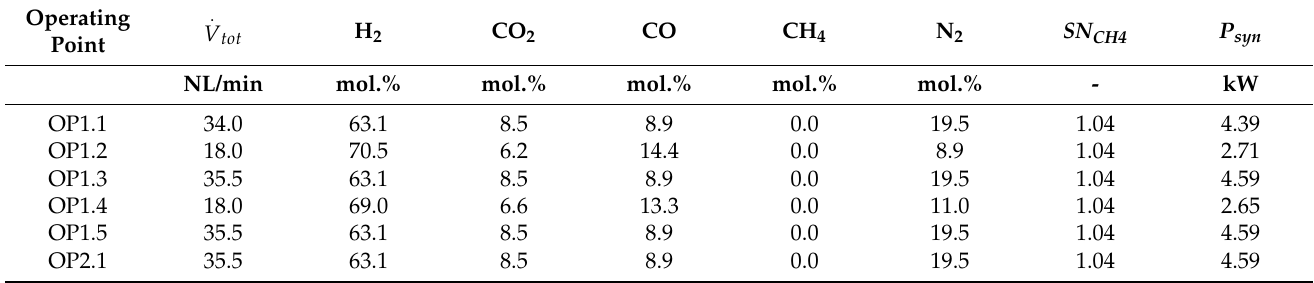
Figure 14. SC1. Handover values received from DC (solid lines) and set values of MFC (dashed lines) for FAU_CH4_TR. Table 2. FAU_CH4_TR operating points defined for the evaluation; mean set values specified by the DC. p = 4 bar for all operating